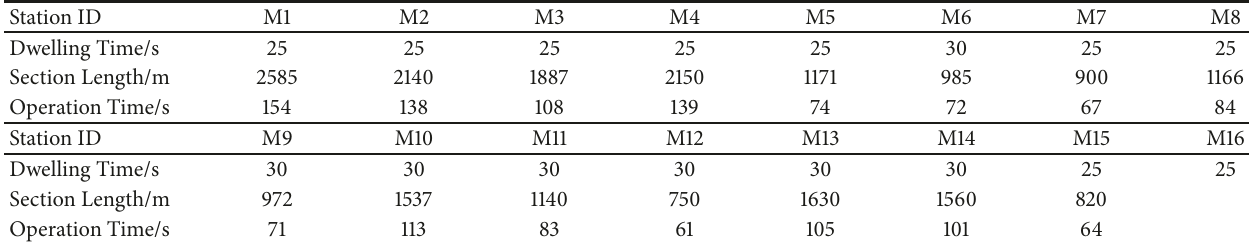
Table 2: Basic information of line 4, phase 1 in Chengdu Metro.